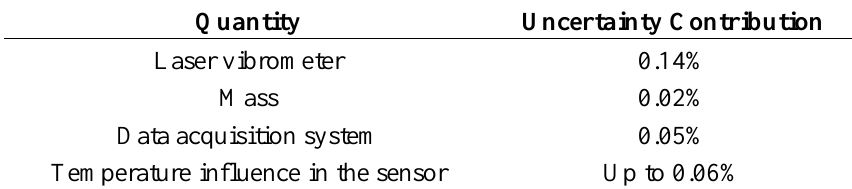
Table 1. Type B uncertainty contributions for the sensitivity modulus.